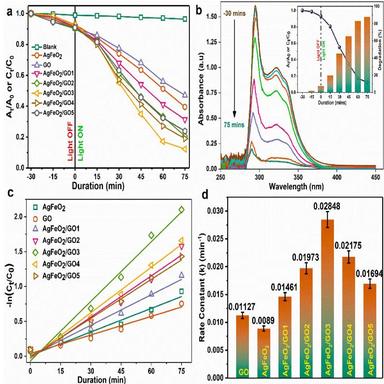
Photocatalytic degradation of LMF, (a) rate of degradation obtained for AgFeO2, GO, AgFeO2/GO1, AgFeO2/GO2, AgFeO2/GO3, AgFeO2/GO4, and AgFeO2/ GO5, (b) UV–Vis absorbance spectra at different time intervals during LMF photodegradation with AgFeO2/GO3 catalyst, (c) pseudo-first-order kinetic modeling for degradation results obtained, and (d) comparison of rate constants acquired.